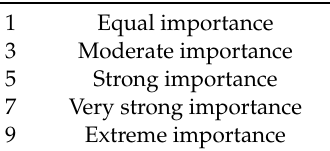
Table 1. Fundamental scale [48].